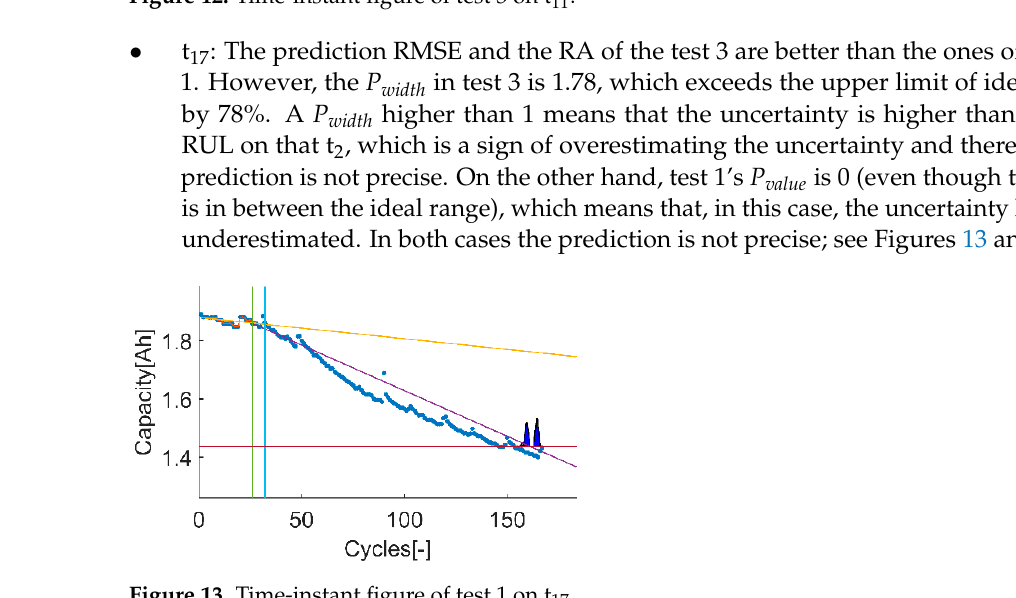
Figure 14. Time-instant figure of test 3 on t 17 .